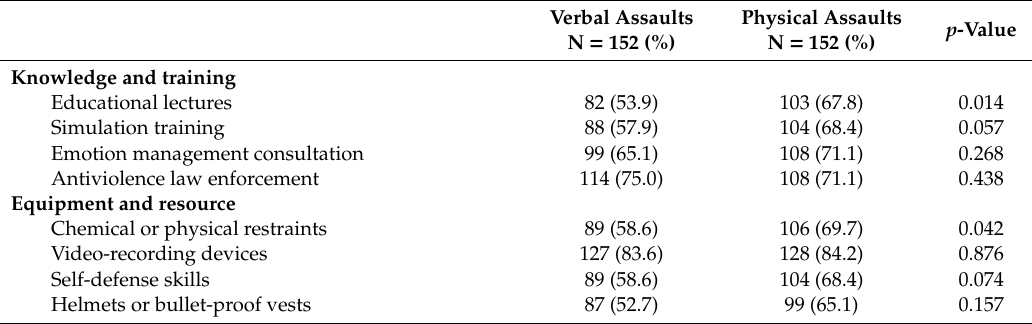
Table A2. Strategies to prevent workplace violence in emergency medical services